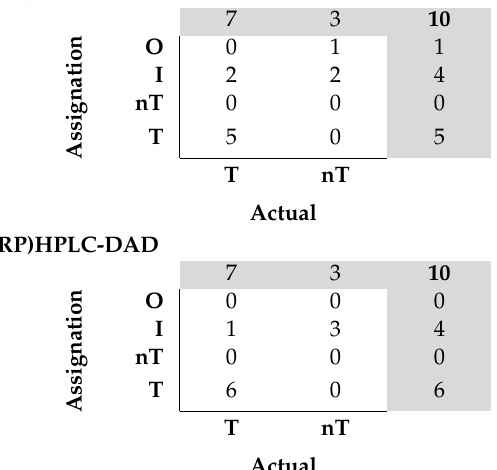
Table 4. Soft independent modelling of class analogy (SIMCA) classification results for the validation set.